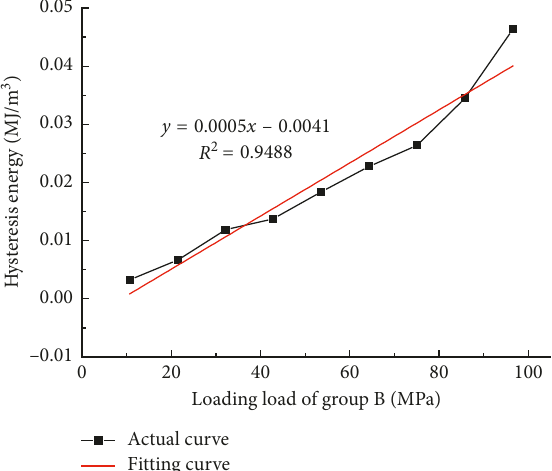
Figure 4: Curve of hysteresis energy and stress of